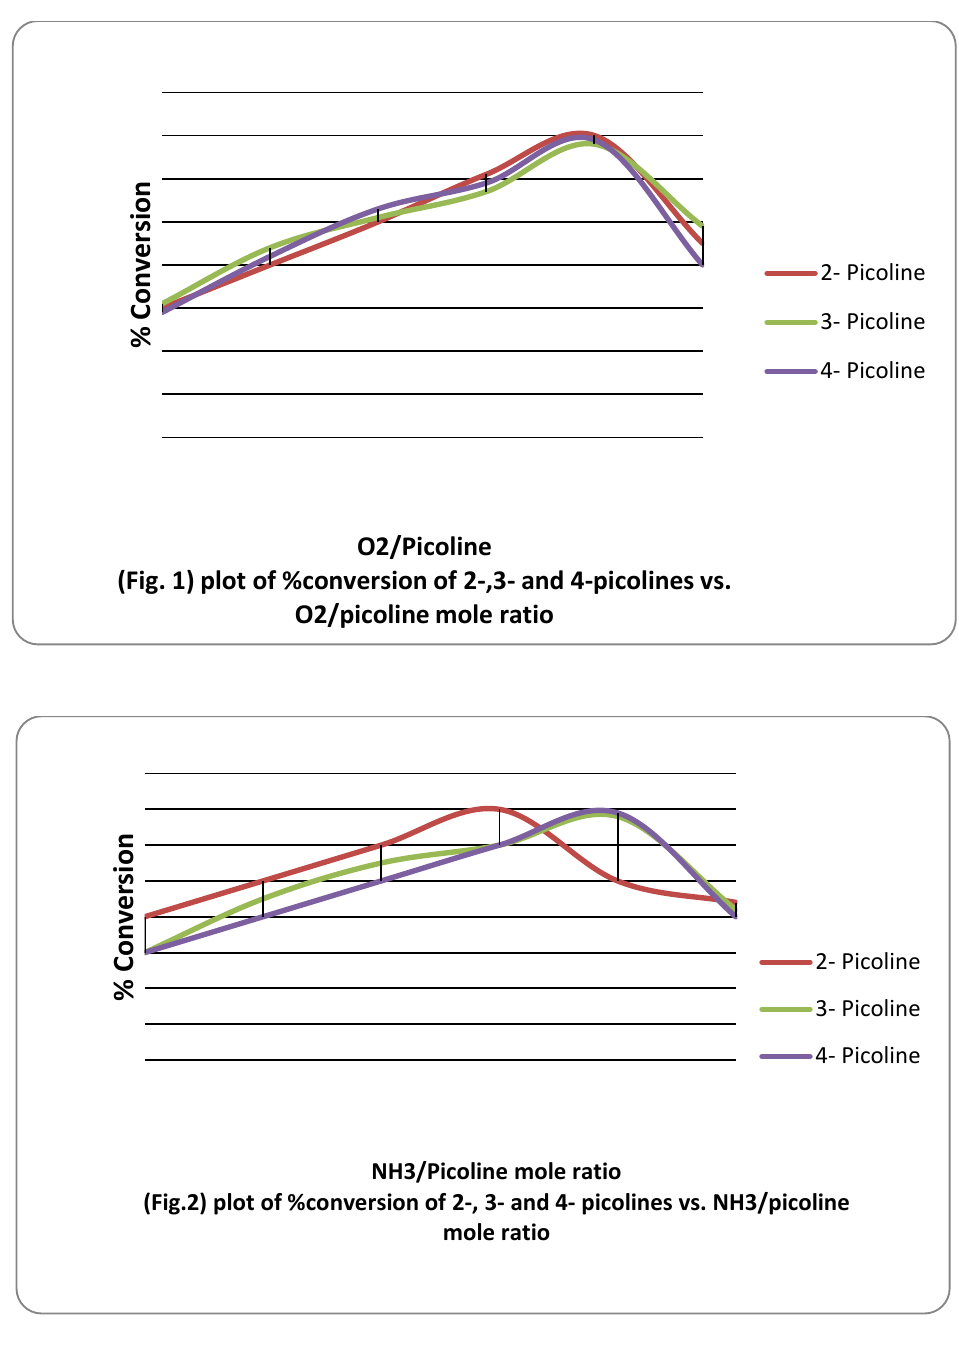
(Fig.2) plot of %conversion of 2-, 3- and 4- picolines vs.